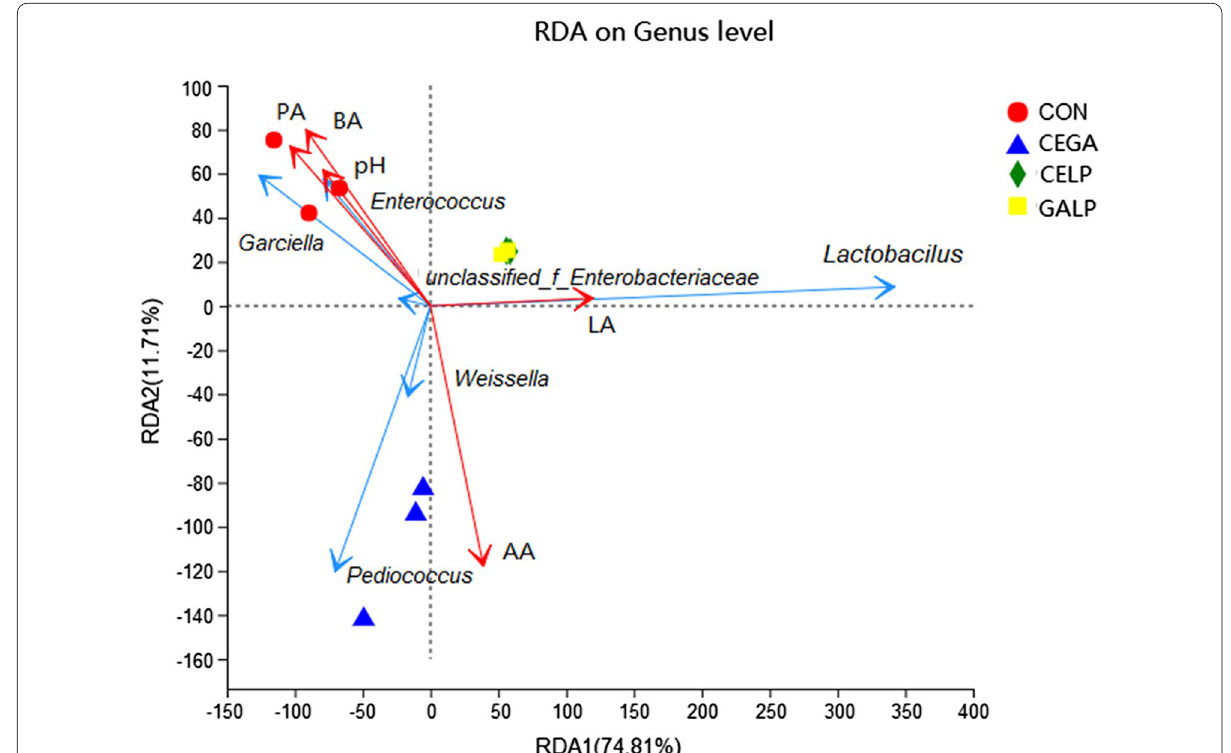
Fig. 4 Correlation analyses between microorganisms and fermentation products in alfalfa silage. LA lactic acid, AA acetic acid, PA propionic acid, BA butyric acid, CON untreated silage, CEGA cellulase plus ɑ -galactosidase, CELP cellulase plus L. plantarum , GALP ɑ -galactosidase plus L.